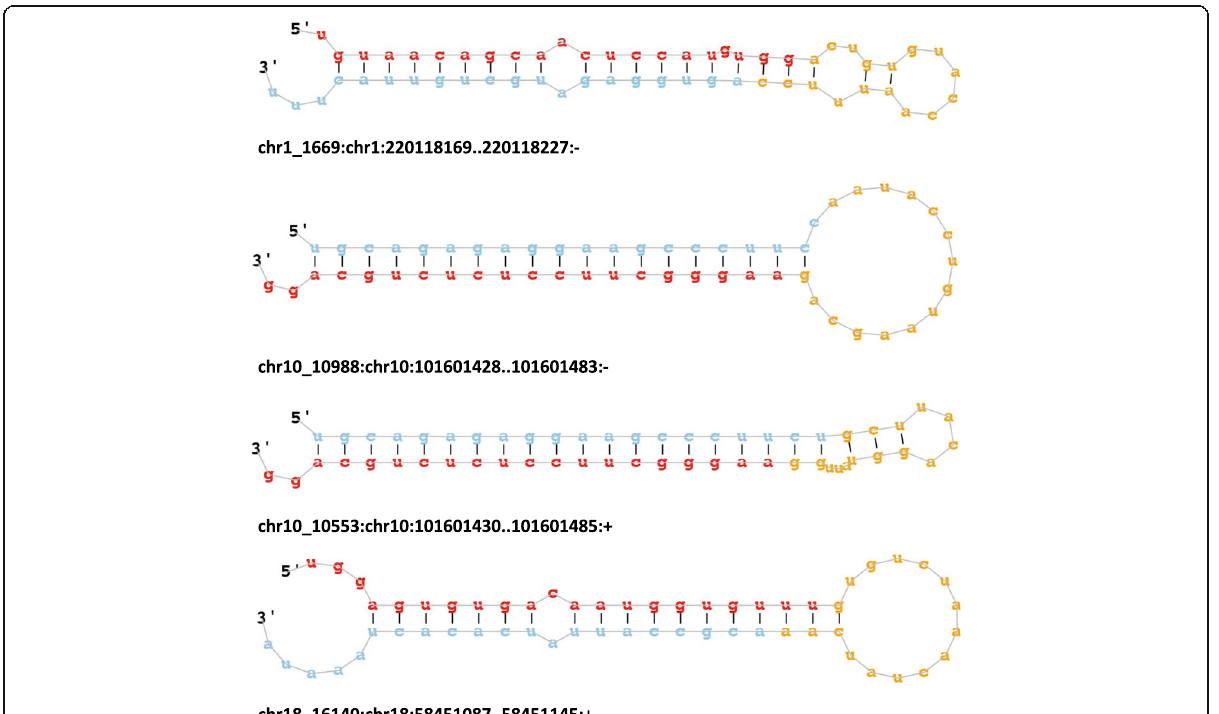
Table 3 List of novel miRNA candidates showing ubiquitous expression Temporary miRNA name (precursor coordinate)